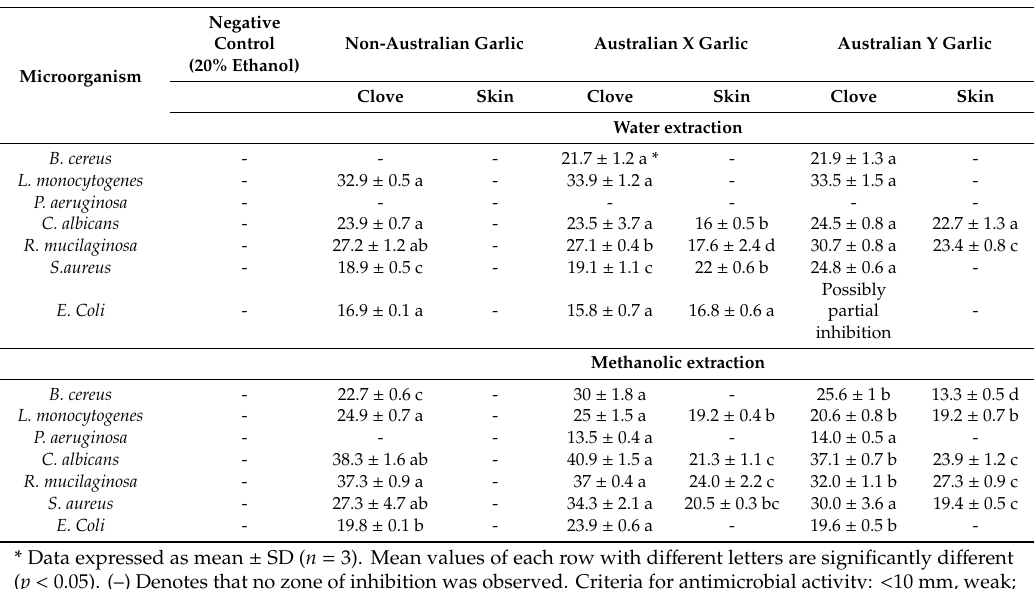
Table 5. Antimicrobial activity of di ff erent garlic samples against food-related microorganisms (inhibition zone in